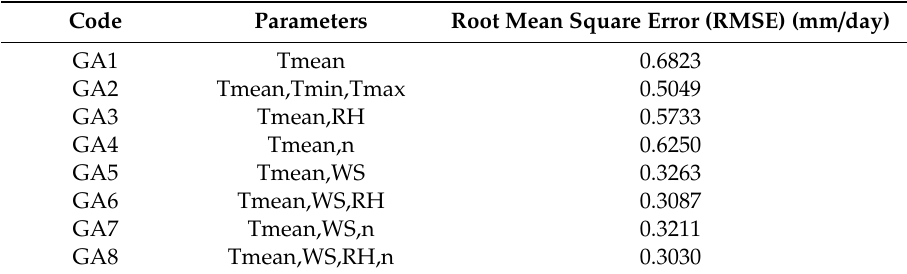
Table 6. Performance of genetic algorithm (GA) for di ff erent parameters.